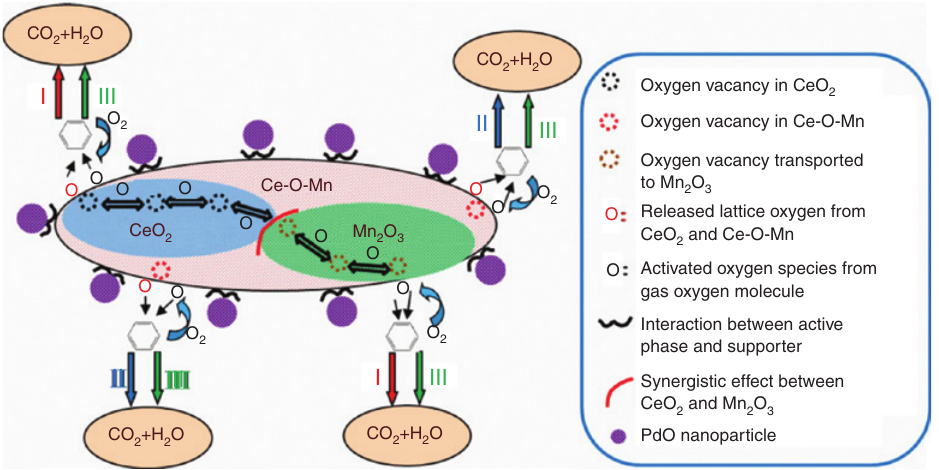
Mn catalysts. Reproduced from [99] with permission from Springer. x 1- x